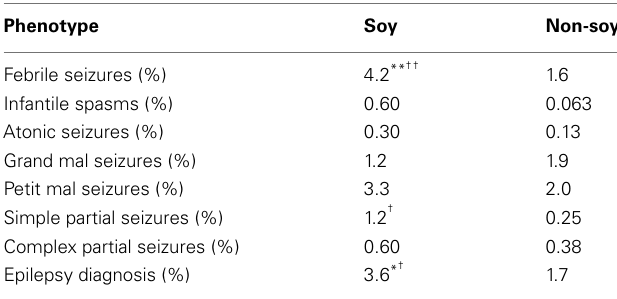
Table 1 | Prevalence of seizures in autism subjects dependent on soy formula